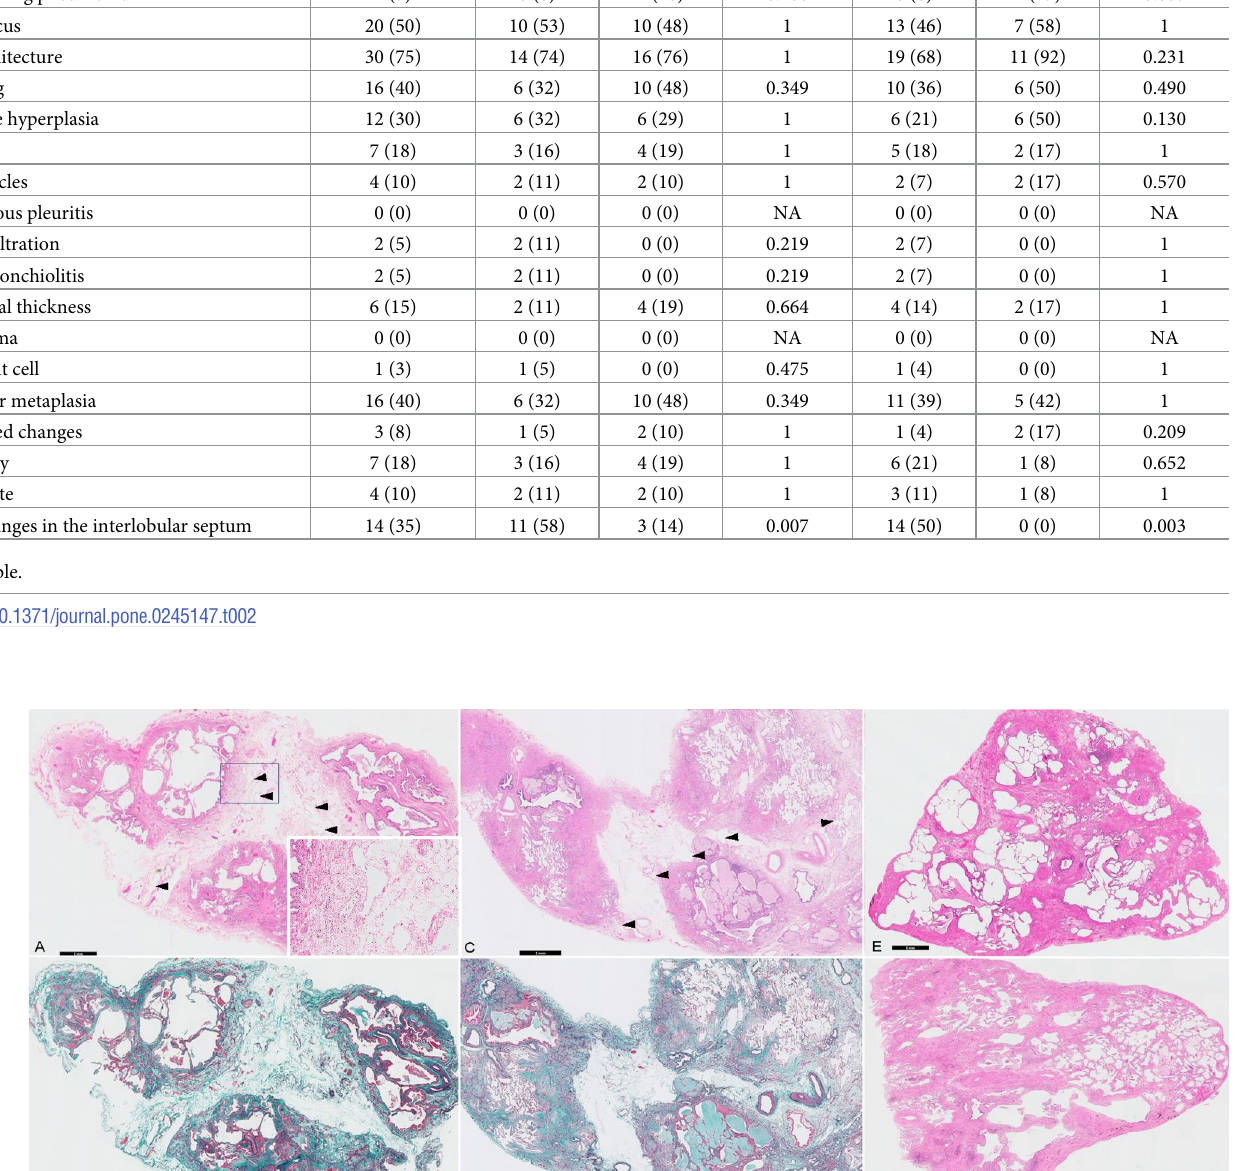
PLOS ONE | https://doi.org/10.1371/journal.pone.0245147 January 7,